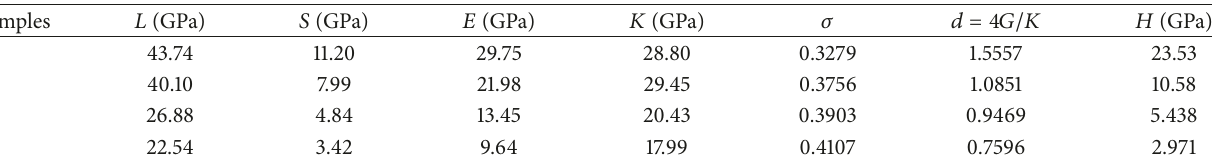
Table 4: Experimental longitudinal modulus ( 𝐿 ), shear modulus ( 𝑆 ), Young’s modulus ( 𝐸 ), bulk modulus ( 𝐾 ), Poisson’s ratio ( 𝜎 ), fractal bond connectivity ( 𝑑 ), and microhardness ( 𝐻 ) of ZnO–SiO 2 samples.